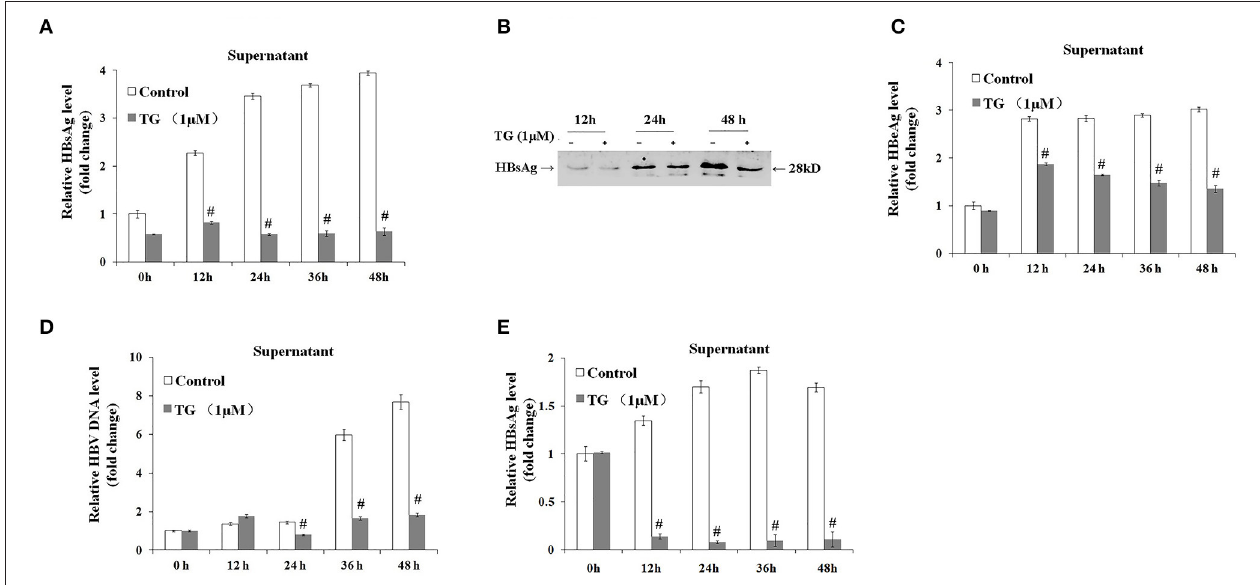
FIGURE 2 | Thapsigargin (TG) inhibited HBsAg, HBeAg, and hepatitis B virus (HBV) DNA secretion in HepG2.2.15 cells and HepAD38 cells. HepG2.2.15 cells and HepAD38 cells were treated with 1 µ M of TG for 12, 24, 36, and 48h. The supernatant levels of HBsAg and HBeAg were determined by ELISA or western blotting, while those of HBV DNA were determined by qPCR. (A) HBsAg levels as determined by ELISA in HepG2.2.15 cells. (B) HBsAg levels as determined by western blotting in HepG2.2.15 cells. (C) HBeAg levels as determined by ELISA in HepG2.2.15 cells. (D) HBV DNA levels as determined by qPCR in HepG2.2.15 cells. (E) HBsAg levels as determined by western blotting in HepAD38 cells. The results are presented as fold-changes compared with the control. Histograms represent the means ± SD of three independent experiments. # P < 0.05 vs. the control.